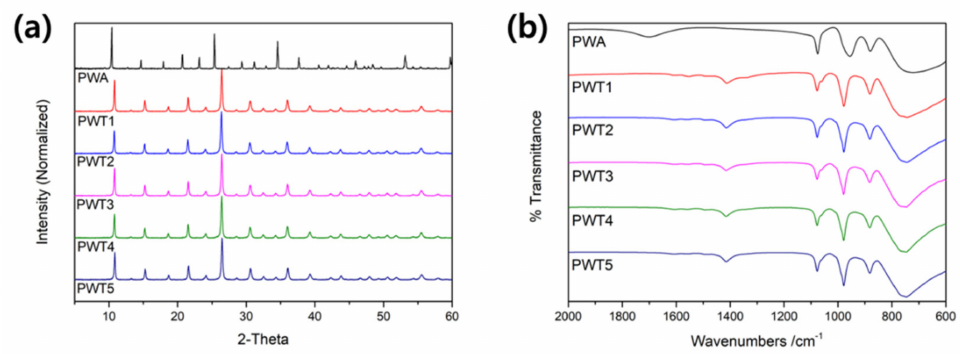
Figure 2. ( a ) X-ray diffraction and ( b ) FT-IR spectra of the PWTx samples. The chemical states of the PWA and triazole-functionalized PWA were verified by X-ray photoelectron spectroscopy (XPS). As shown in Figure 3a for the C 1s spectrum, two peaks associated with C–C and C–N were observed at approximately 284–284.7 and 285.8–286.3 eV, respectively [34]. This change in the C-species bonding indicated the presence of a triazole ring in the triazole-PWA composites. As shown in Figure 3b for the N 1s spectrum, three peaks at approximately 400–401, 401.4–402.2, and 403.1–403.9 eV were observed for the triazole-PWA composites and attributed to C-N, -N= (imine nitrogen) and -N + - (positively charged nitrogen), respectively. After triazole functionalization, the XPS spectrum of N 1s shifted to higher binding energies (by approximately 2 eV), indicating